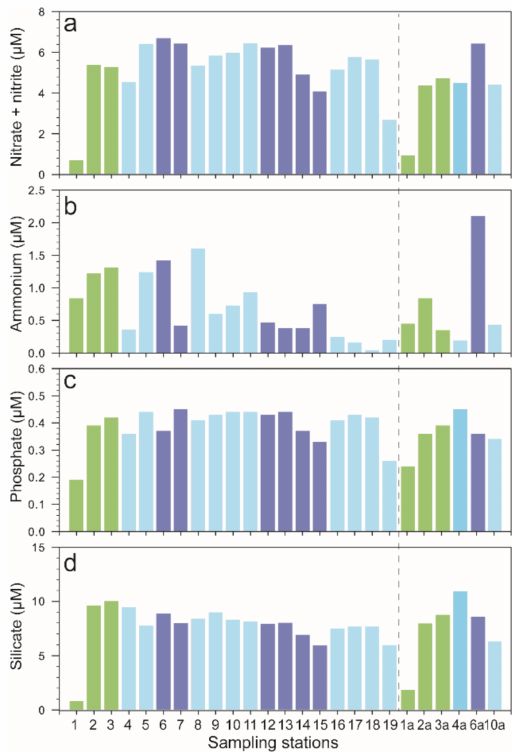
Figure 7. Horizontal distribution of nutrients at sampling stations in the East Sea during early spring (27 February to 5 March). ( a ) nitrate + nitrite, ( b ) ammonium, ( c ) phosphate, and ( d ) silicate. Data after dashed lines indicate resampled stations (Stns. 1a, 2a, 3a, 4a, 6a, and 10a). Bars are color coded by zone as follows: green: CS, light blue: OS, dark blue: IS. Table 2. Abiotic and biotic factors on day 1 and 7 days later (early spring) and 6 days later (late spring). Values are means ± standard errors and results were compared using a t -test. p > 0.05: N.S ;